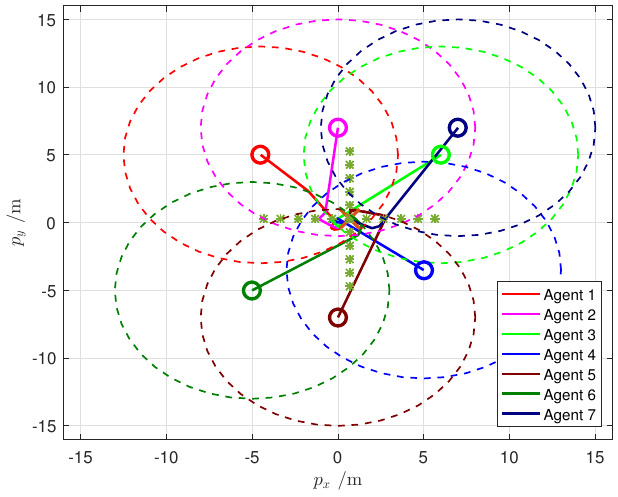
. ( b ) Evaluations of p k x , i